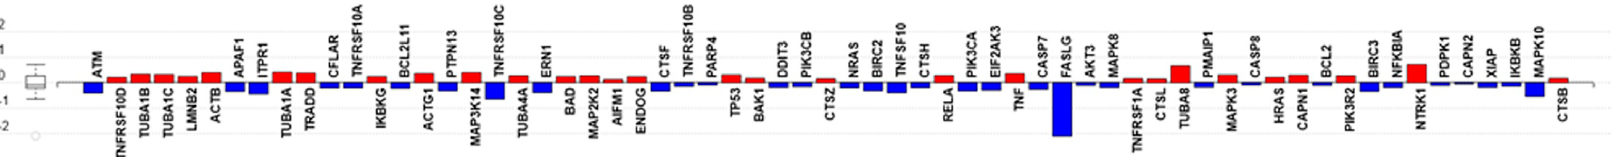
Figure 8. The apoptosis pathway mRNA transcripts regulated in response to C16 ceramide-enriched LDL in human podocytes. Podocytes were induced with C 16 ceramide-enriched or native LDL and RNA-seq assay was performed as described in Figure 3 legend. Figure generated by iPathwayGuide (Advaita Bioinformatics) software; log FC, logarithm of fold change of gene expression. Box and whisker plot: the ends of the box are the upper and lower quartiles, box spans the interquartile range. Horizontal line inside the box denotes the median and the whiskers are the two lines outside the box extend to the highest and lowest observations.